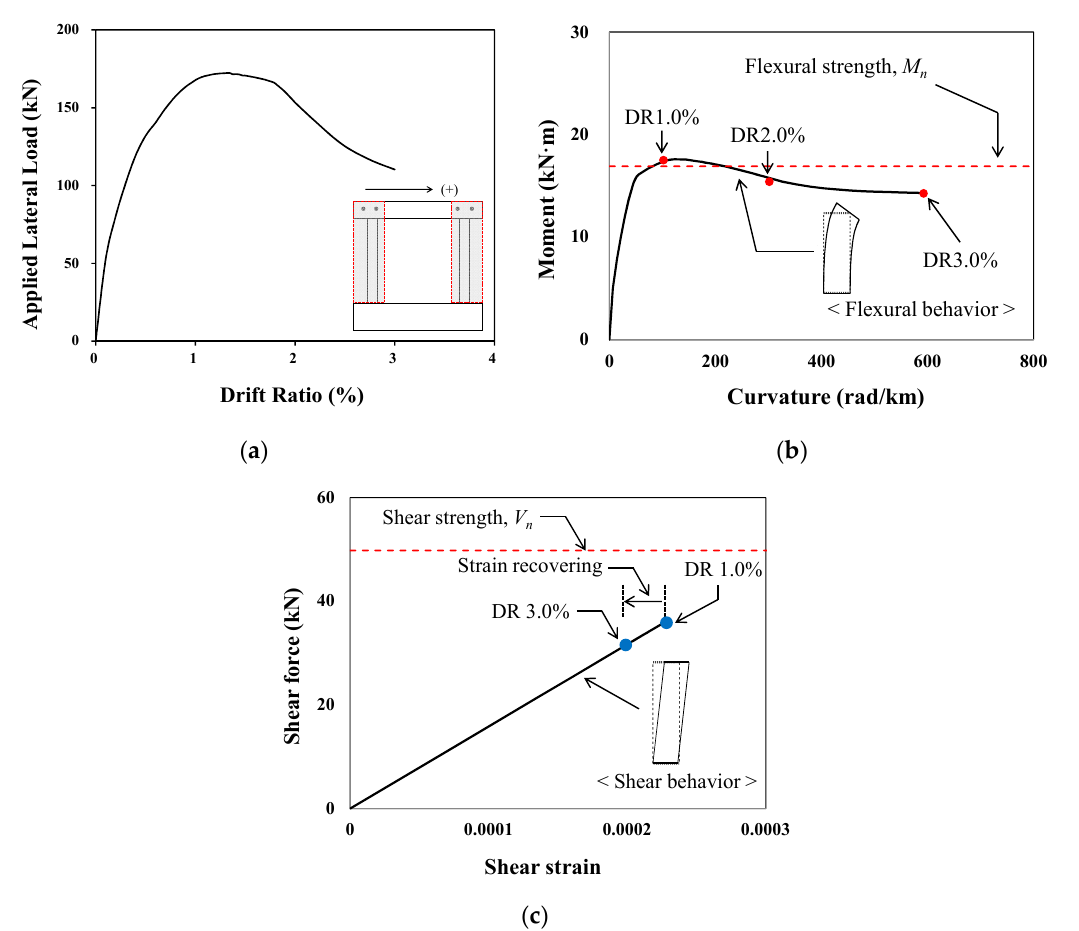
Figure 18. Flexural and shear behavior of column element in Specimen FPB: ( a ) pushover; ( b ) flexural behavior; ( c ) shear behavior.